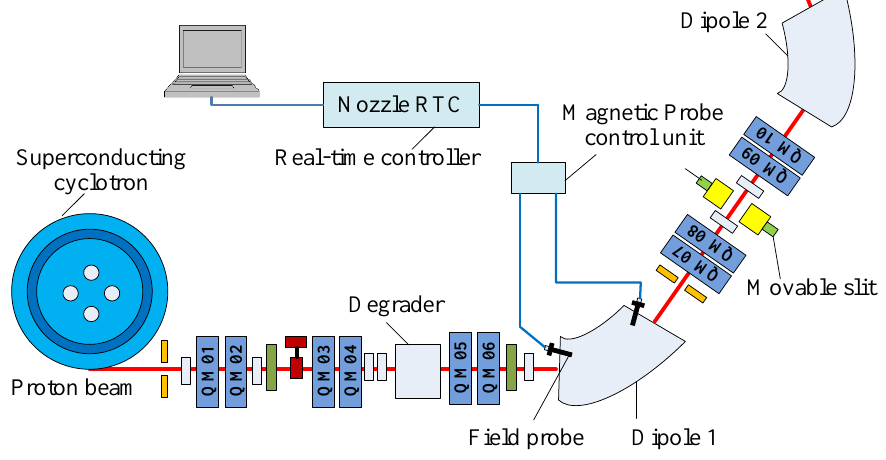
Figure 1. Schematic of the part of the energy selection system (ESS) in 200 MeV superconducting cyclotron (SC200).